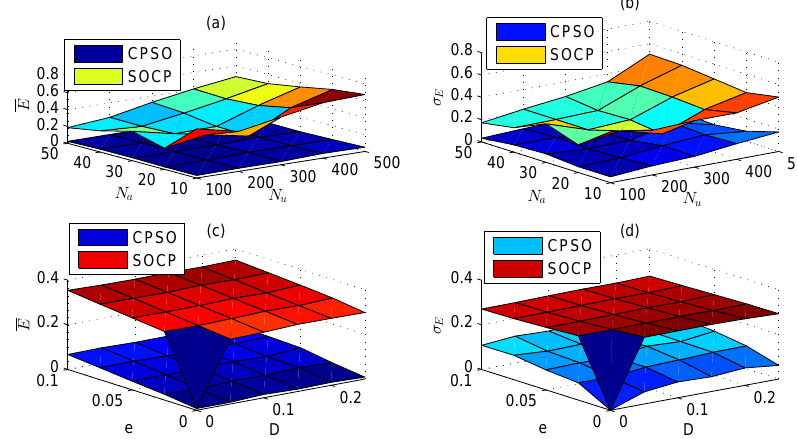
Figure 9. Comparison of CPSO and SOCP. ( a ) E of different N U and N A ; ( b ) σ E of different N U and N A ; ( c ) E of different D and e ; ( d ) σ E of different D and e